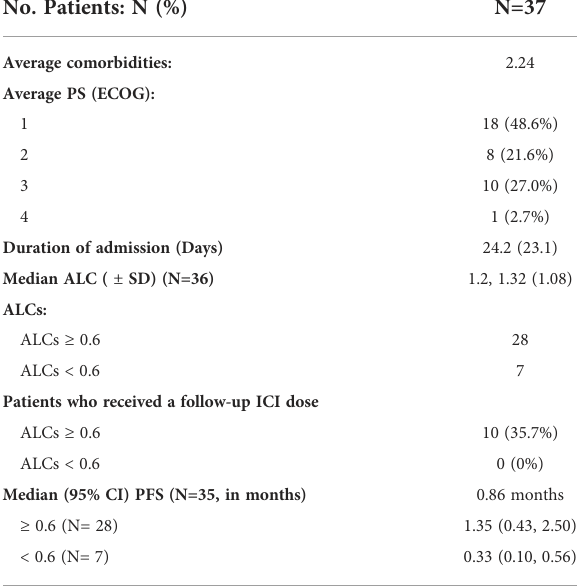
TABLE 2 Patient clinical and laboratory treatment